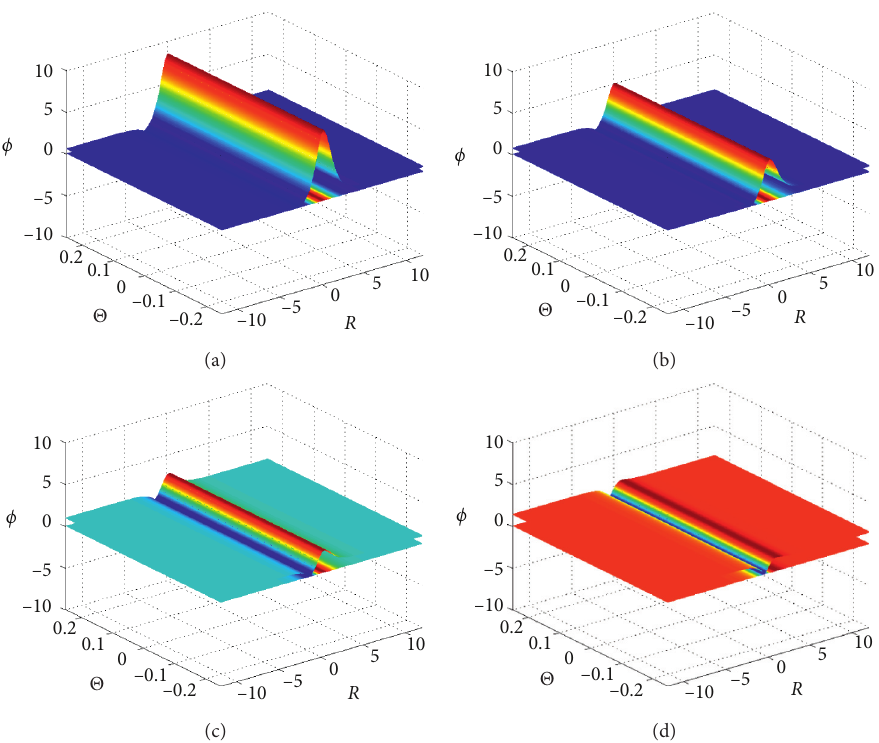
Figure 3: The values of the parameters are as follows. (a) β � 1 . 2, λ � 1 . 1, ω � 1, and ϖ � 1. (d) β (c) β 1